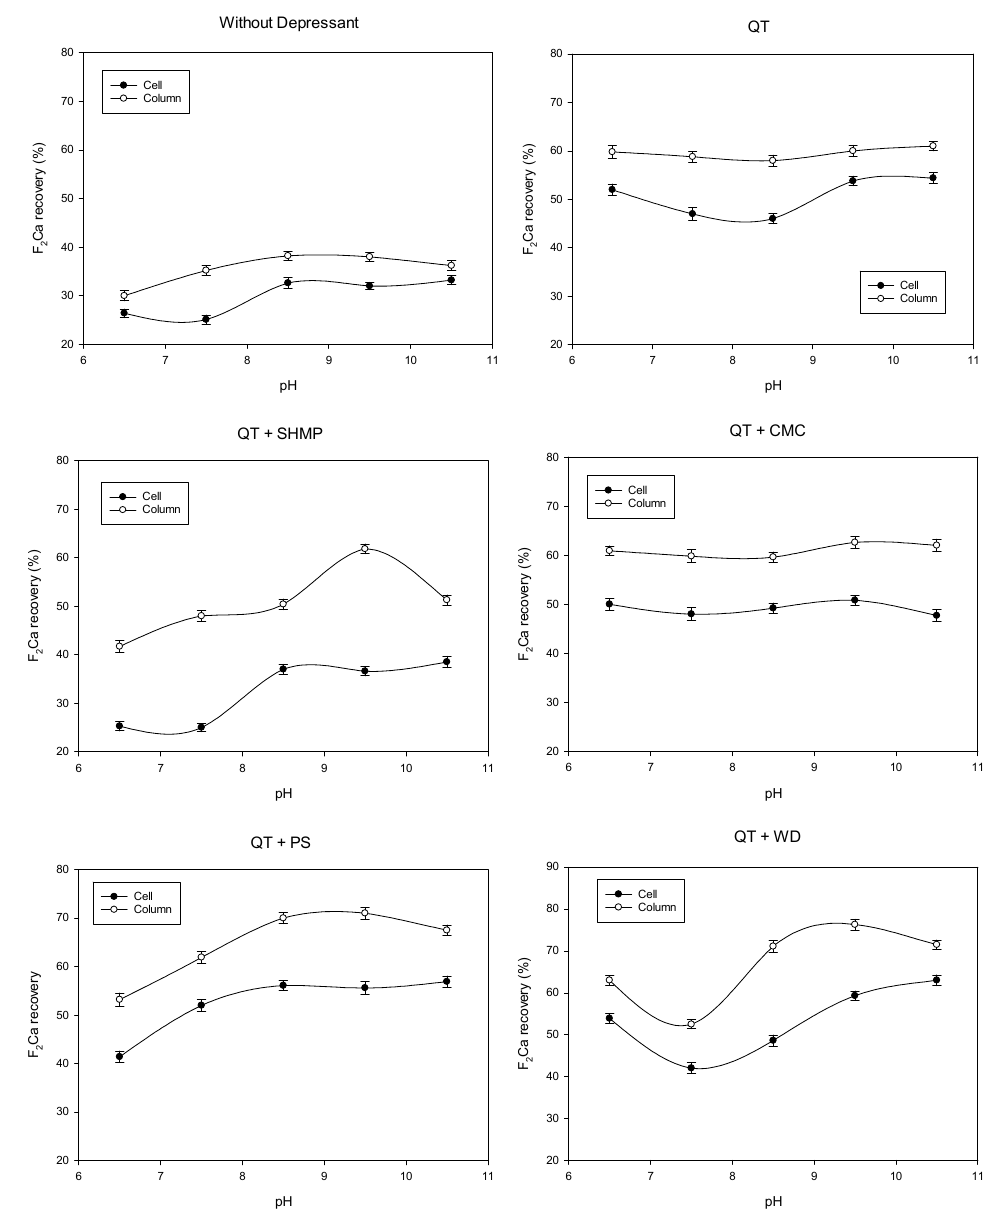
Figure 2. Metallurgical recovery for cell and column as pH function and type of